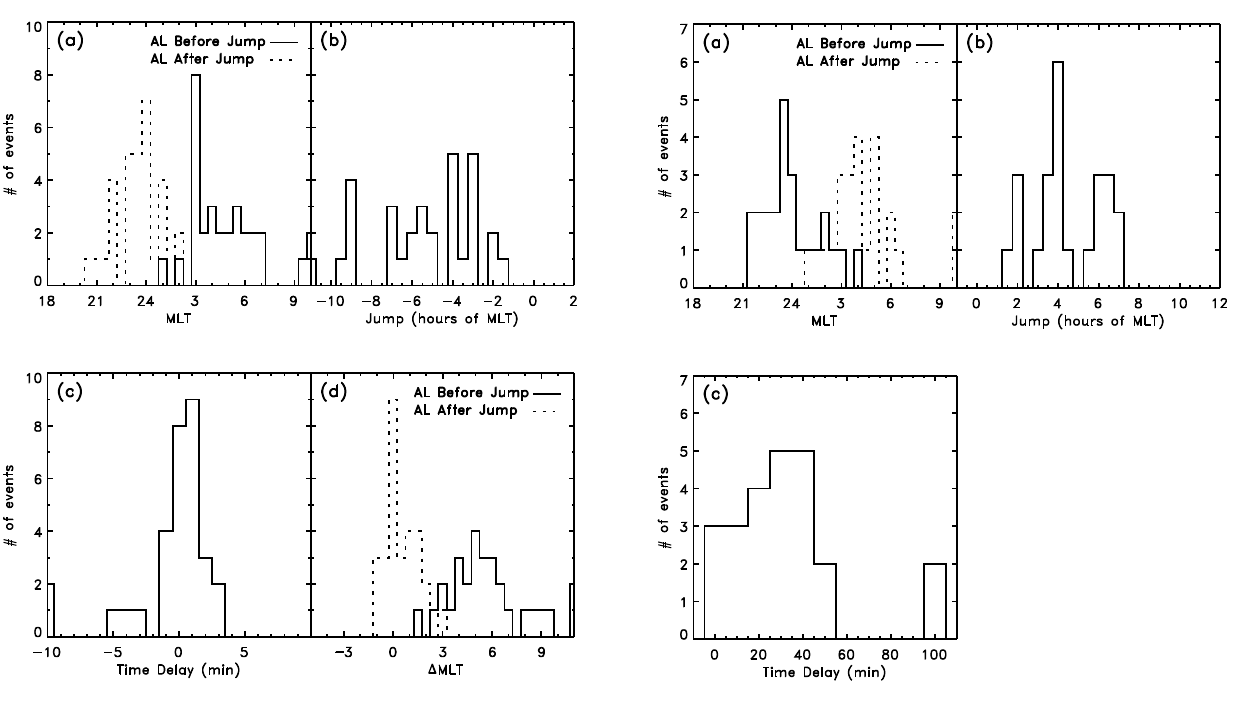
Fig. 4. Panels (a) through (c) are all related to the eastward AL jump during the substorm recovery phase. Panel (a) shows the distribu- tions of the location of the AL defining station before and after the jump; panel (b) shows the change in location (position after jump minus position before jump); panel (c) shows time of the AL jump minus time of end of expansion